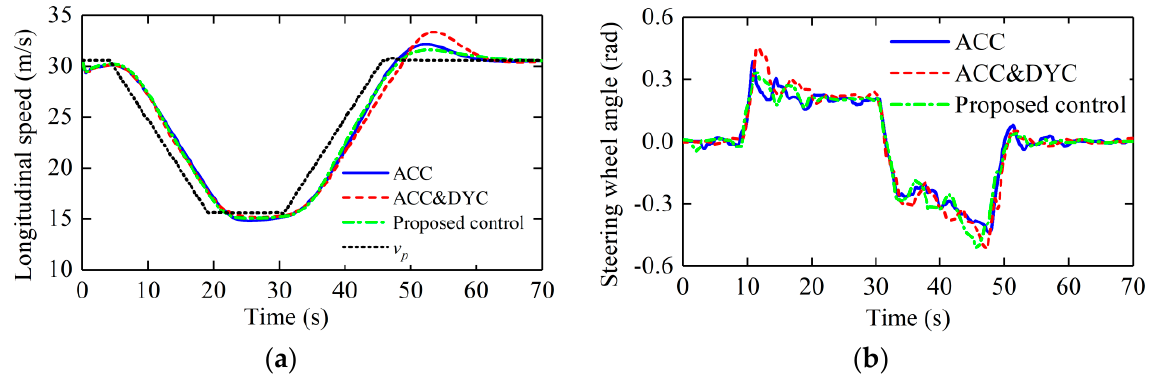
Figure 12. Longitudinal speed and steering wheel angle: ( a ) longitudinal speed; ( b ) steering wheel angle. The longitudinal car-following errors, lateral stability error and phase plane of errors are shown in Figures 13-15, respectively.